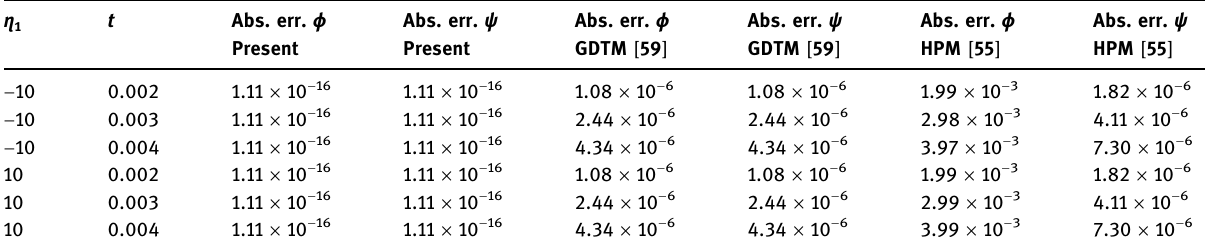
Table 2: Comparison of absolute errors regarding Example 1 η t Abs. err. ϕ 1